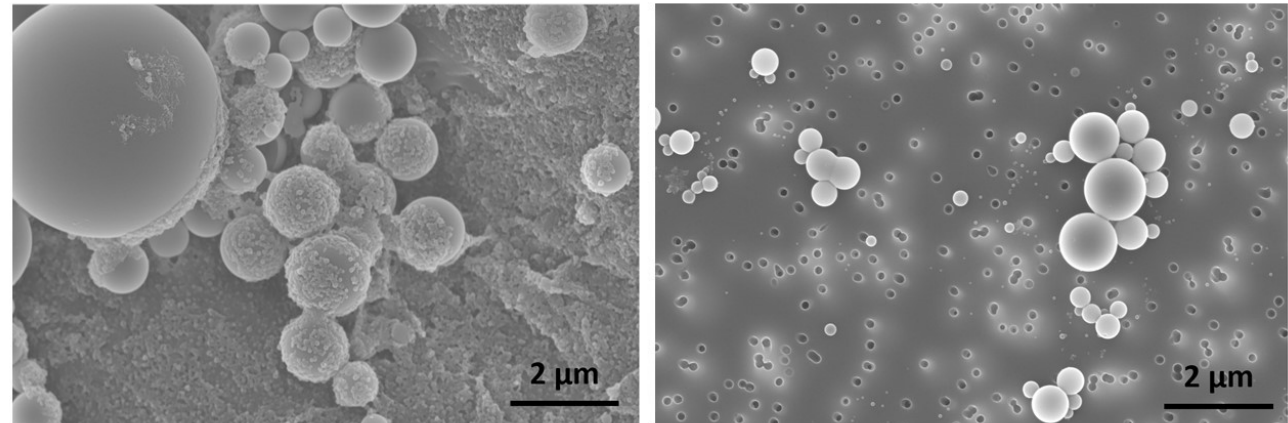
Figure 2. Exemplary SEM images of PS-b-PAA vesicles (prepared via the co-solvent method with 16.2 wt% water, and a polymer concentration of 0.05 wt% in the solvent THF) without centrifugation ( left ) and with centrifugation ( right ), to study the purification procedure.